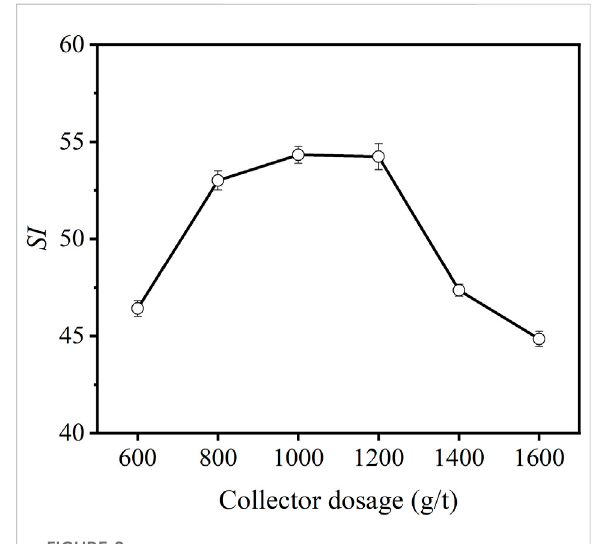
FIGURE 8 Effect of collector dosage on SI of carbon anode slag fl otation (grinding time 40 min, feed solid concentration 140 g/L, frother dosage 500